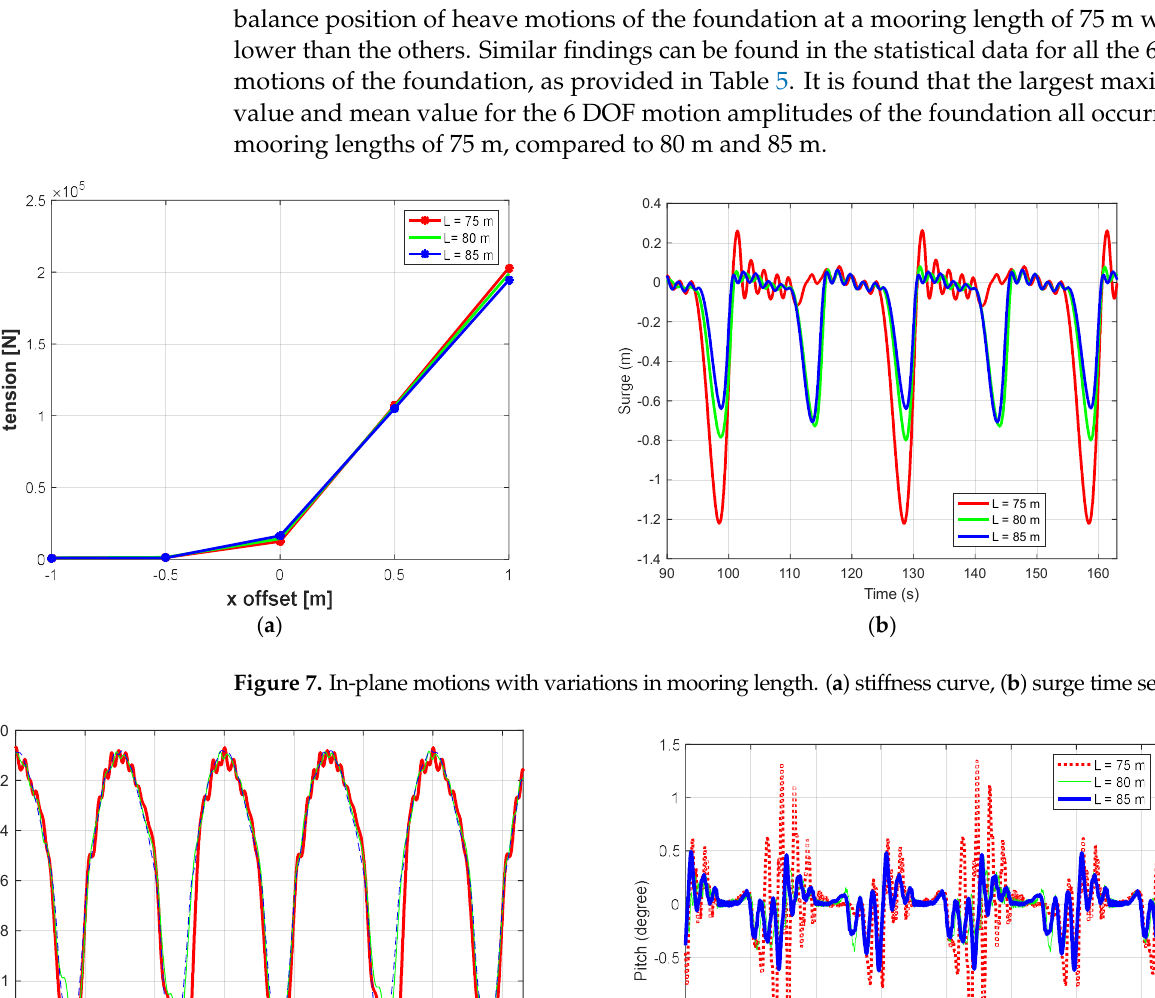
Figure 6. Mooring configuration with different lengths at L1 = 75 m, L2 = 80 m and L3 = 85 m.